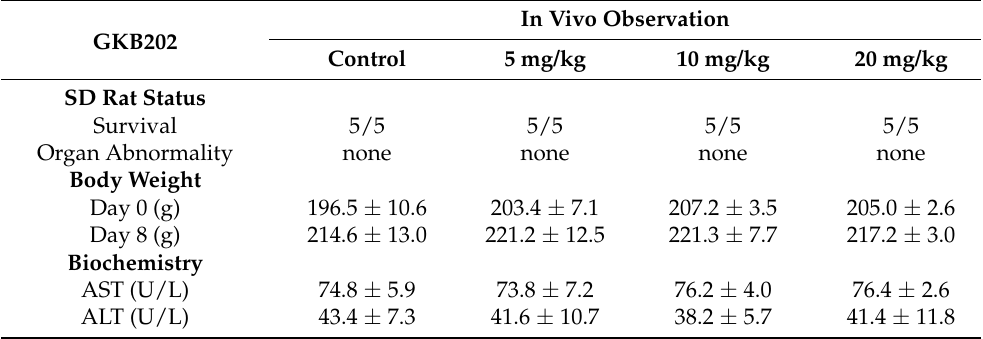
Table 2. In vivo observation after GKB202 compound supplementation in different dosage.